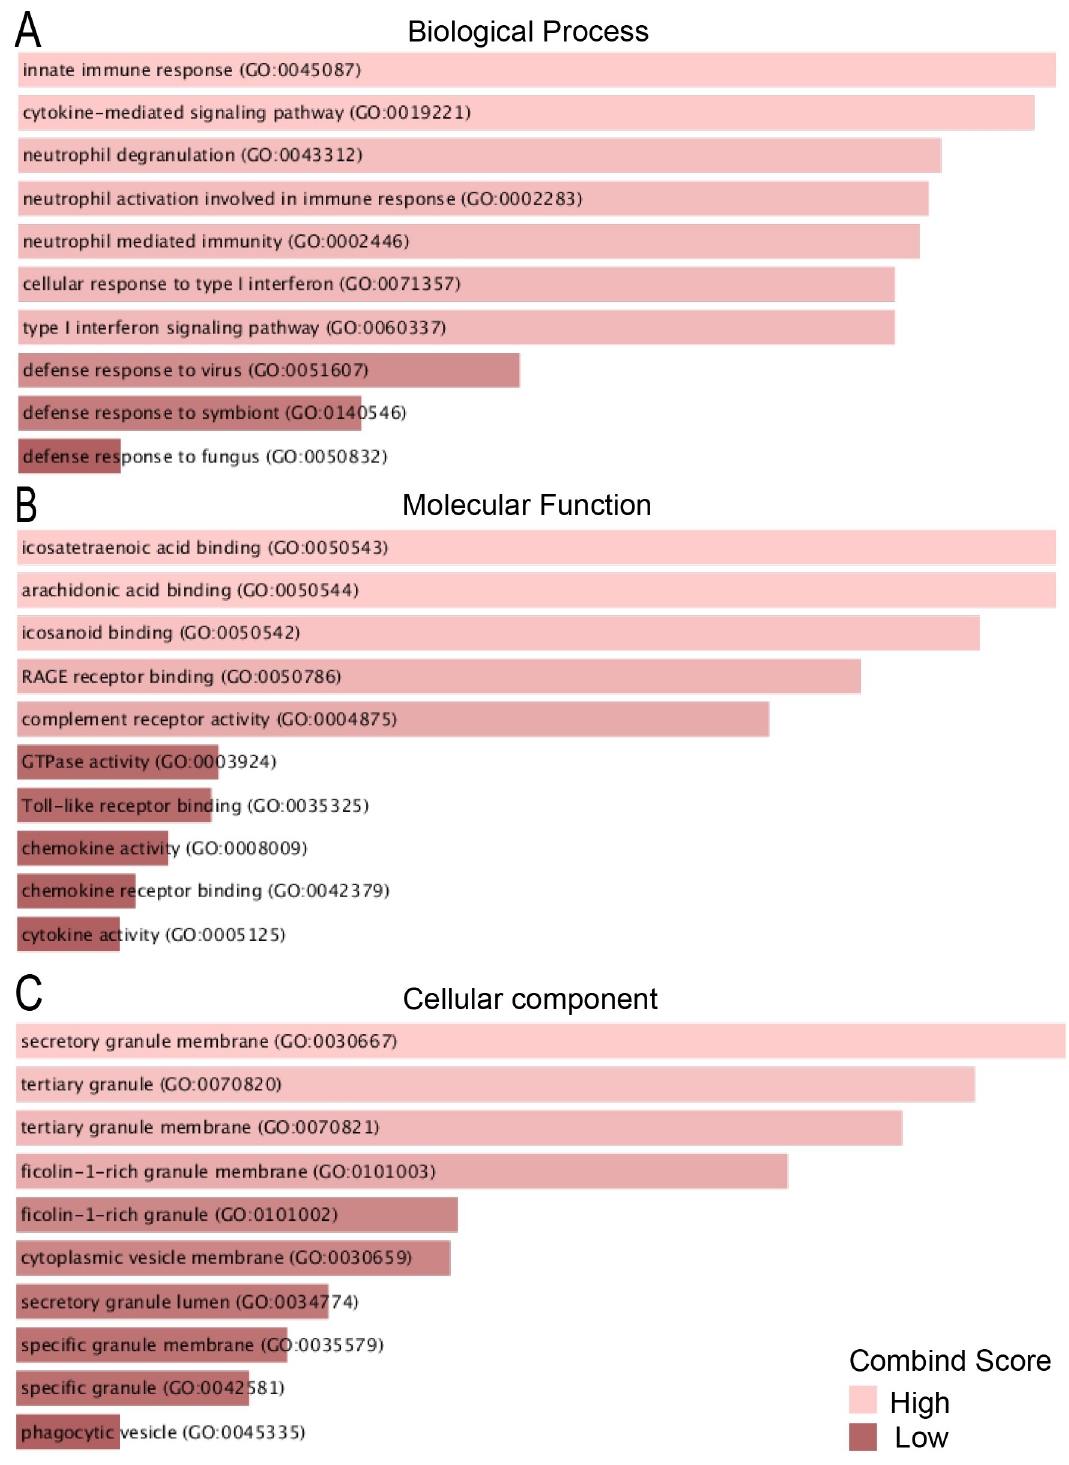
Fig 4. GO terms of upregulated DEGs between COVID-19 and IPF. A: GO analysis of upregulated DEGs related to biological process. B: GO analysis of upregulated DEGs related to molecular function. C: GO analysis of upregulated DEGs related to cellular